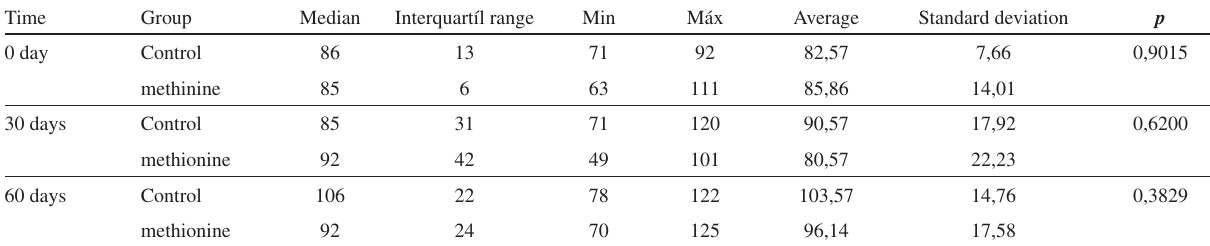
Table 2 - Total cholesterol levels (mg/dl)